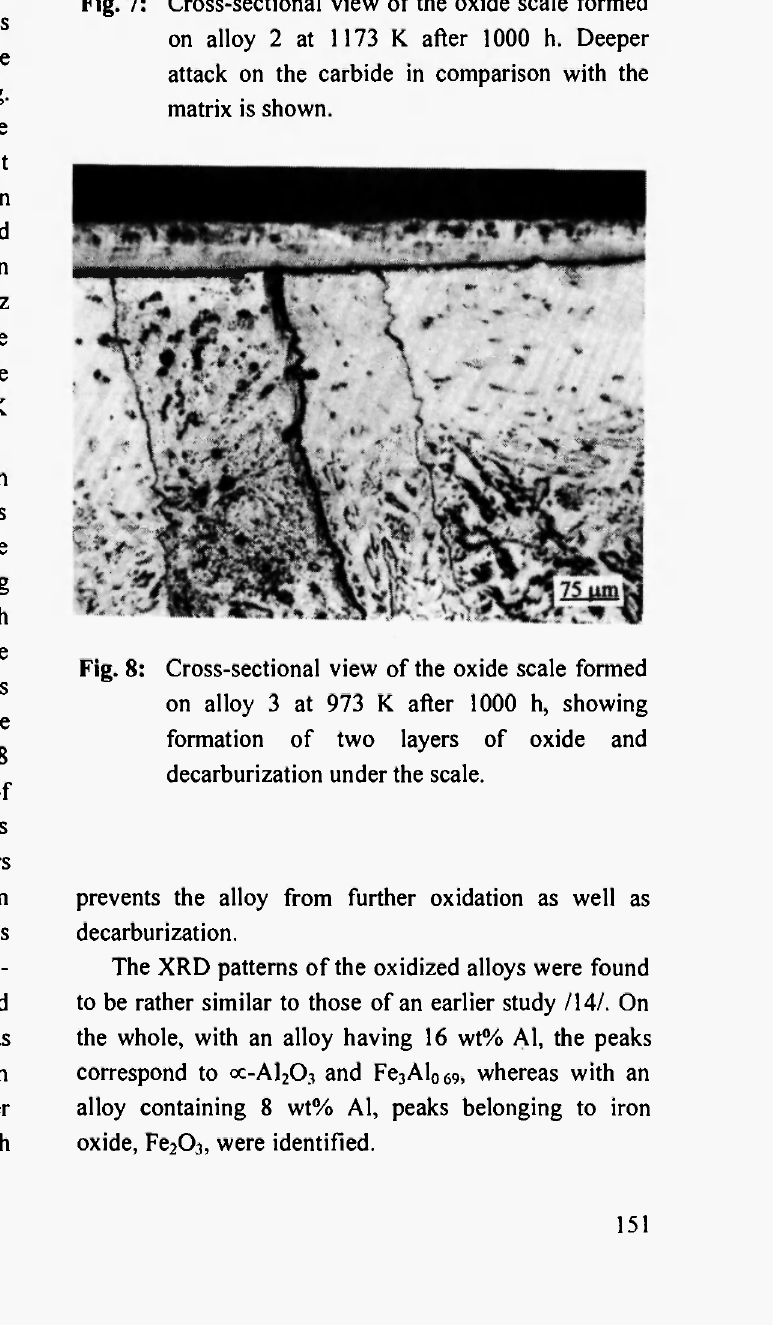
Fig. 7: Cross-sectional view of the oxide scale formed on alloy 2 at 1173 Κ after 1000 h. Deeper attack on the carbide in comparison with the matrix is shown.